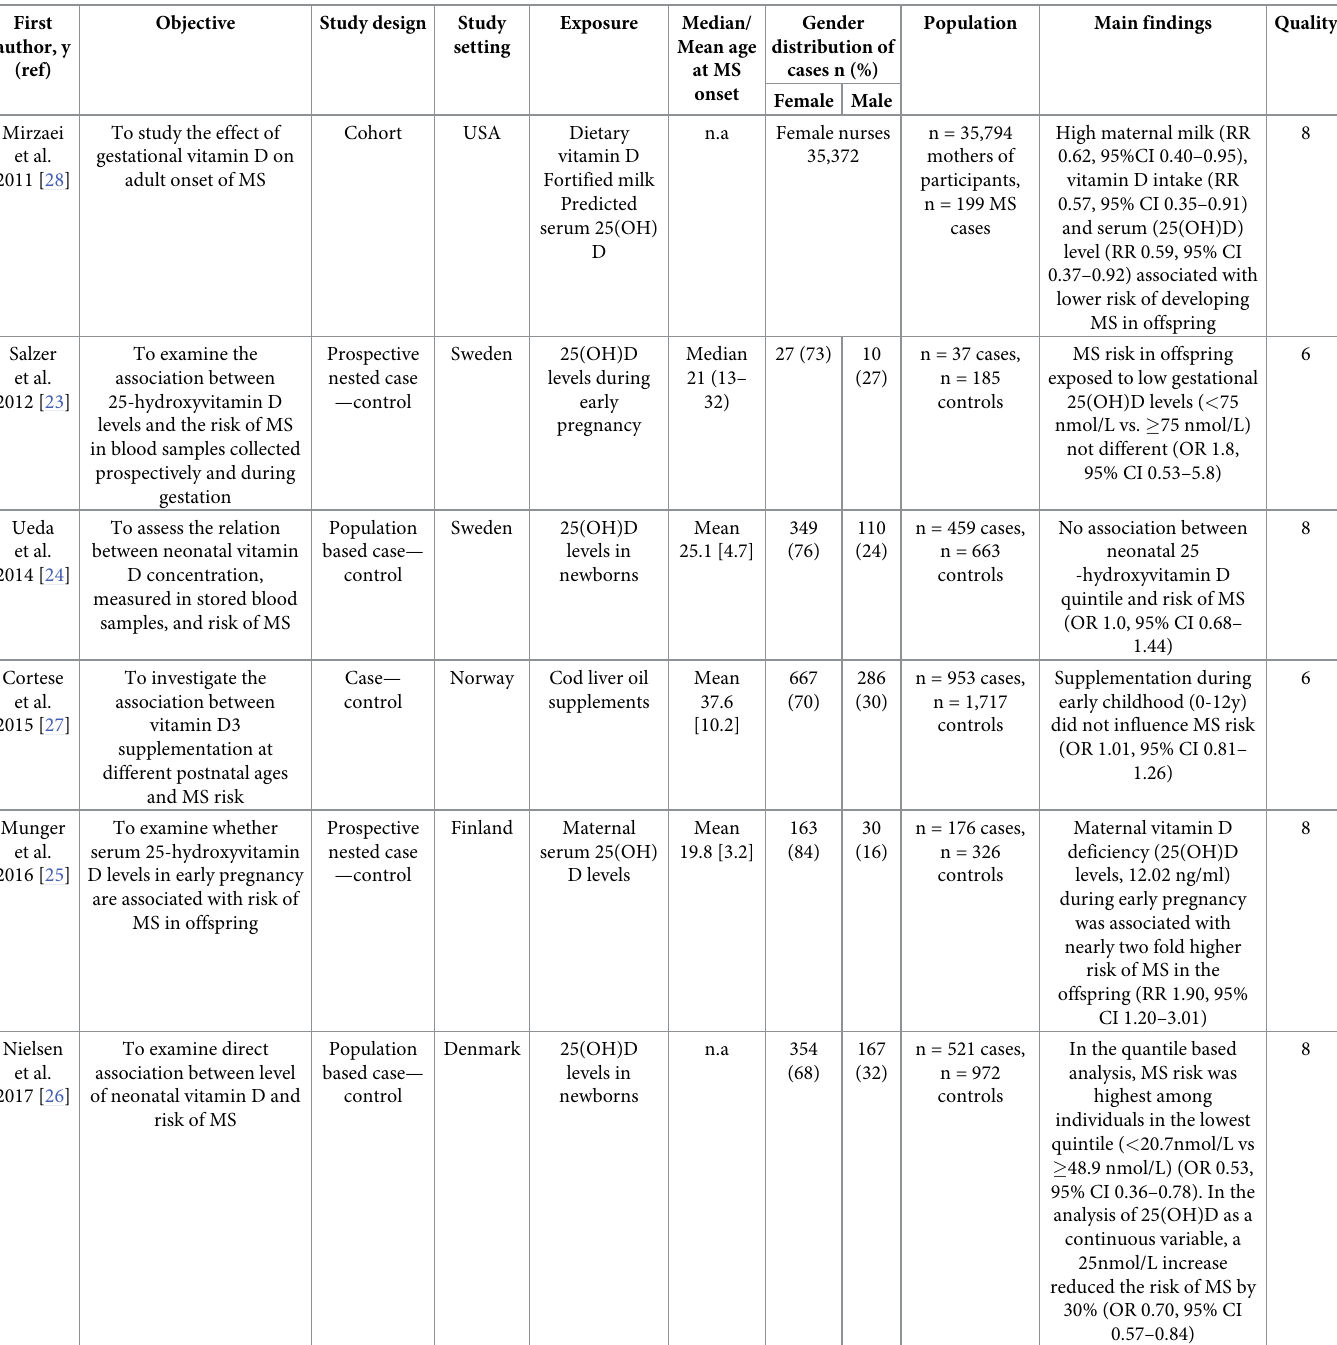
Table 1. Characteristics of population studies investigating influence of vitamin D availability in early life and the risk of MS in